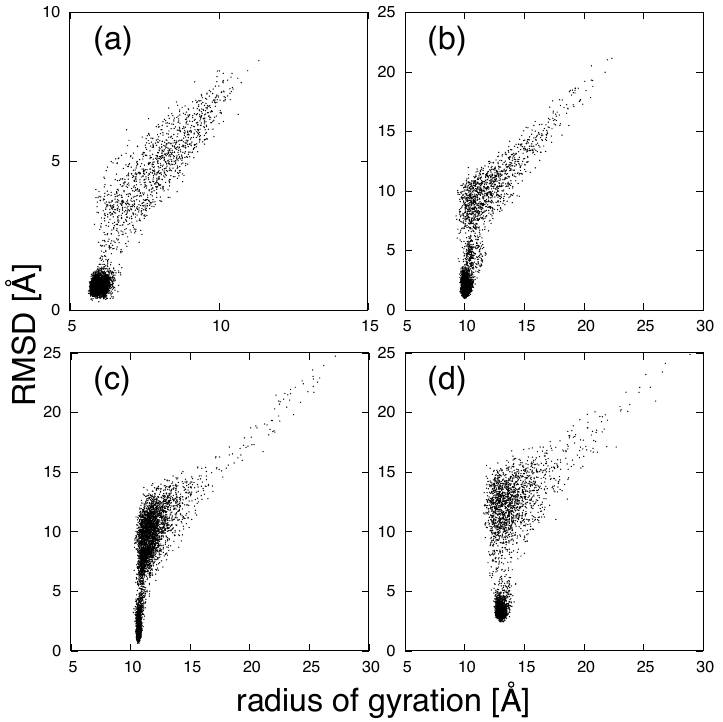
Figure 1. C α -RMSD of ( a ) CLN025, ( b ) mGTT, ( c ) mNuG2, and ( d ) m α 3D as a function of the radius of